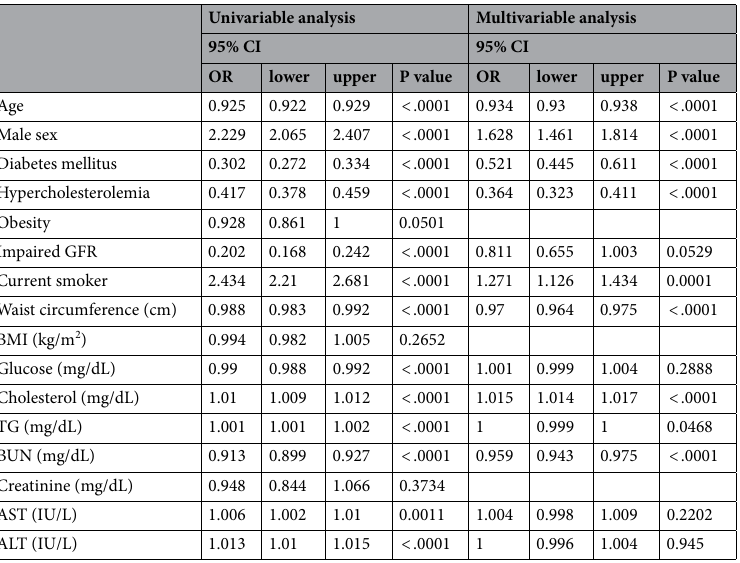
Table 2. Uni- and multivariable logistic regression analysis to identify factors affecting hypertension treatment. OR odds ratio, CI confidence interval, GFR glomerular filtration rate, SBP systolic blood